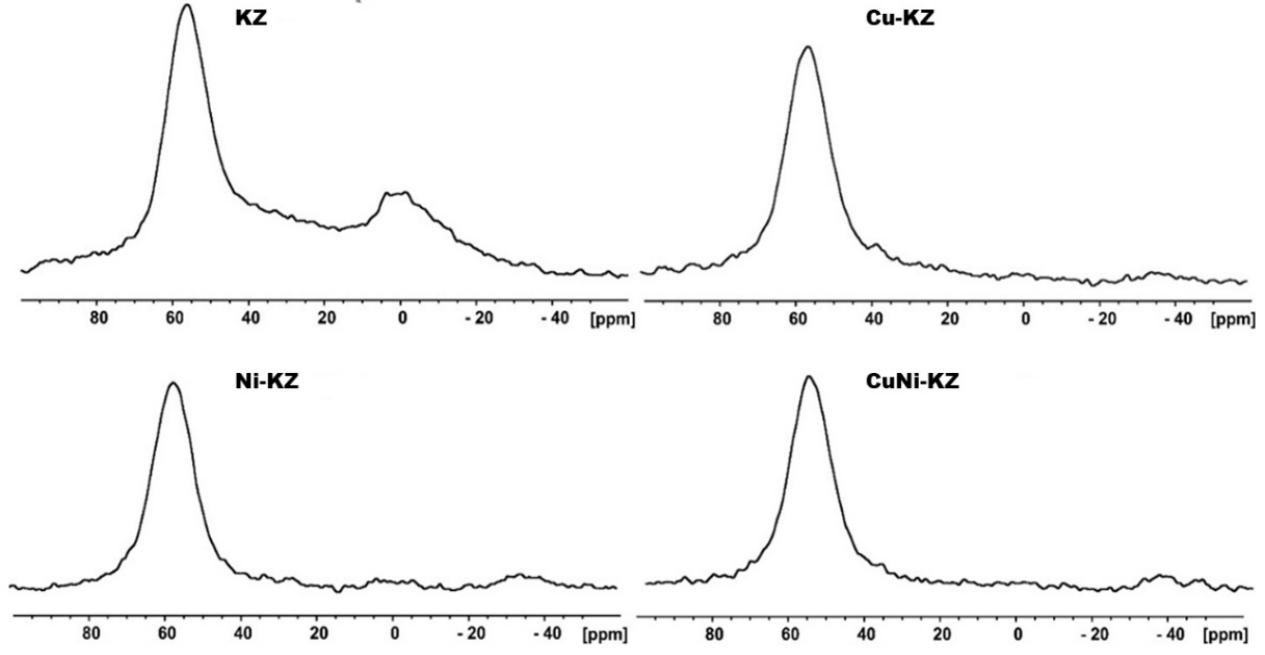
Figure 6. The 27 Al NMR spectra of the studied zeolites.